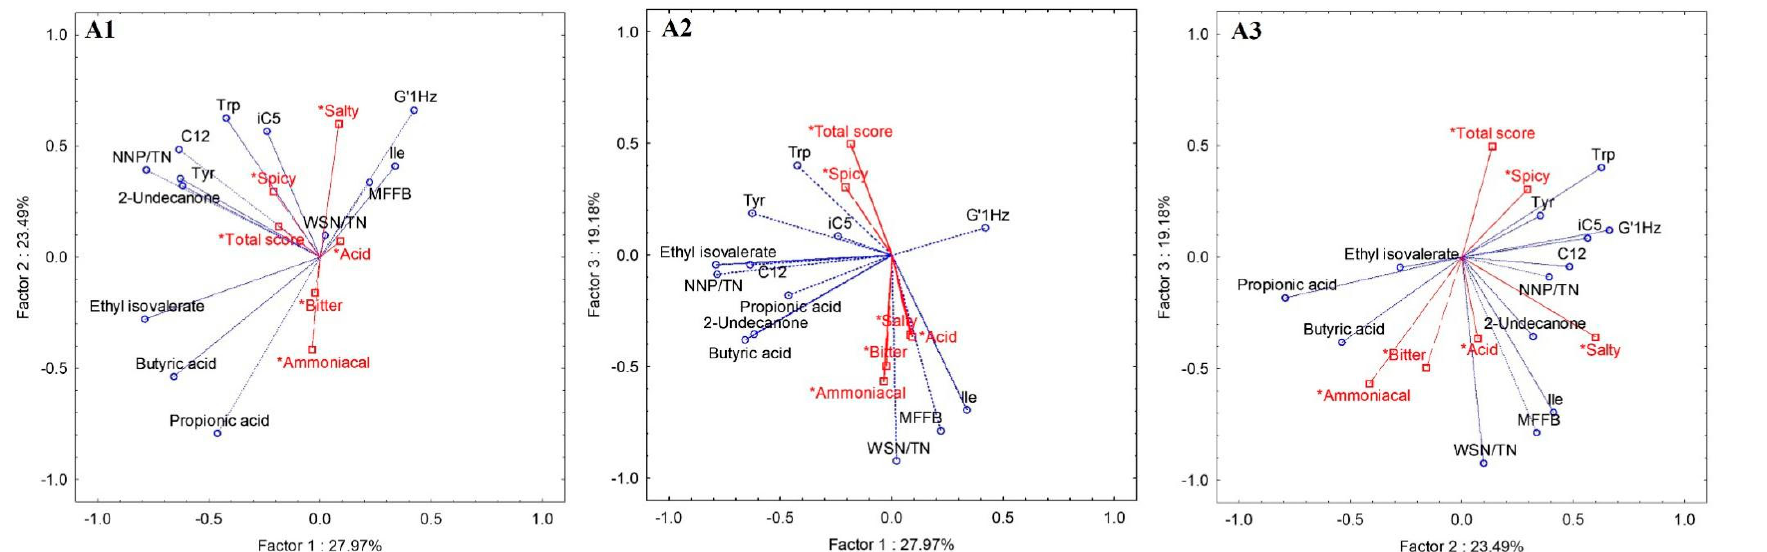
Figure 3. Variable projection of principal component analysis (o active variables, □ * supplementary variables): PC1 vs. PC2 ( A1 ), PC1 vs. PC3 ( A2 ) and PC2 vs. PC3 ( A3 ). Tyr-tyrosine; Trp-tryptophane; Ile-isoleucine; iC 5 -isobutyric acid; C 12 -dodecanoic acid; NPN-non-protein nitrogen; TN-total nitrogen; WSN-water-soluble nitrogen; MFFB-moisture content on a fat-free basis. The parameter “total score” was the supplementary